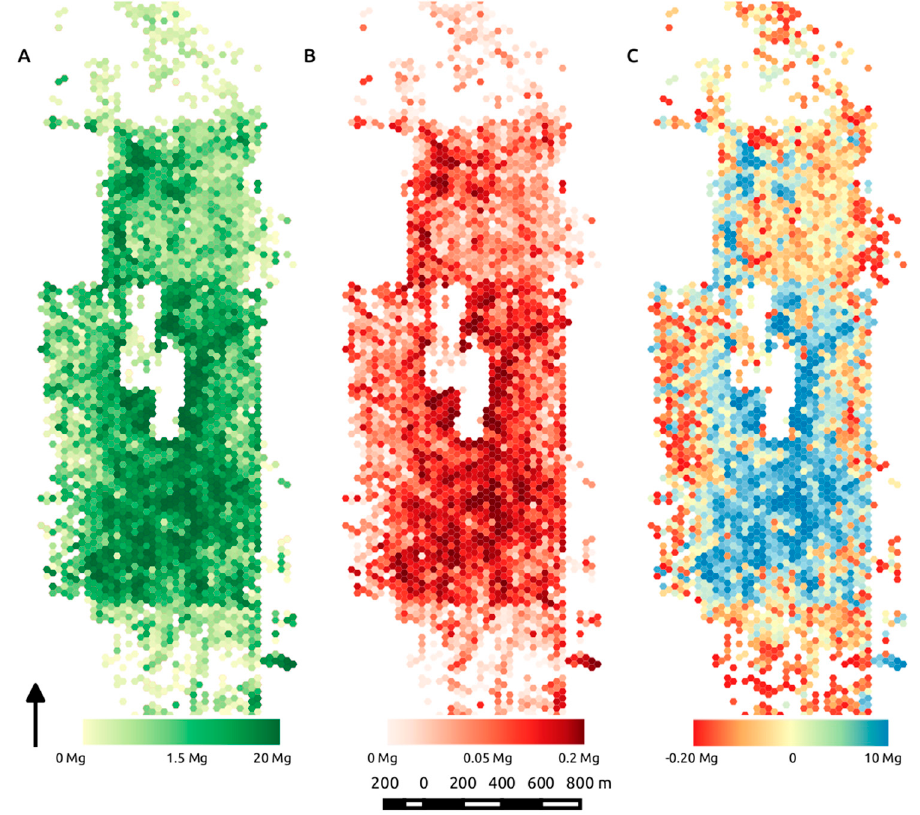
Figure 10. Mapped mean biomass (Mg AGB) binned into roughly 0.08-ha hexels across the analysis extent derived from the best predictors of equivalent stem diameter, volume and density ( A ) and the corresponding mean standard deviation for the mean AGB in each hex ( B ); ( C ) highlights the difference between biomass predictions using ESD as a function of volume only, vs . ESD derived from volume and density, calculated as Vol — Vol D , where the resulting difference is expressed in terms of Mg AGB.